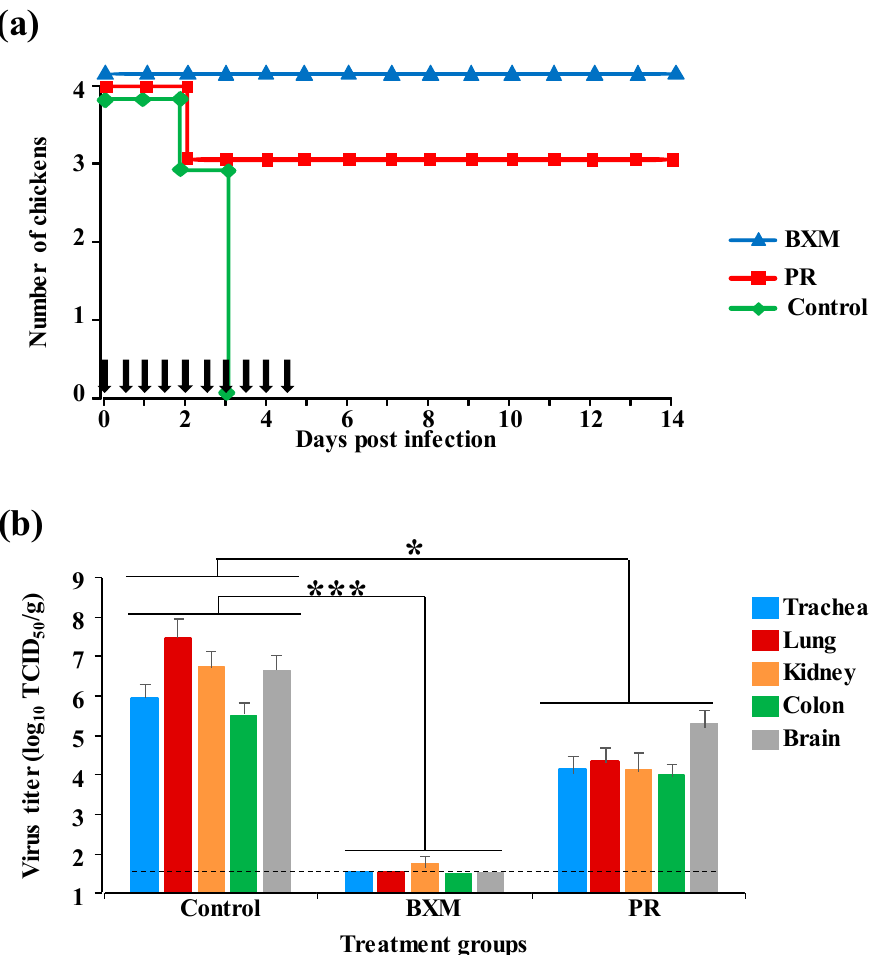
Figure 1. Effects of the simultaneous treatment using multiple doses of baloxavir marboxil (BXM) or peramivir (PR) in chickens infected with a high pathogenicity avian influenza virus (HPAIV), A/BS/Akita/1/16. Eight chickens per group were infected with 10 CLD 50 /100 µL (10 5.3 EID 50 ) of the HPAIV and treated immediately with 20 mg/kg of either BXM or PR; the untreated group was assigned as the control. ( a ) Survival of half the infected birds was followed until 14 days post-infection (dpi); vertical black arrows indicate the treatment schedule. ( b ) Virus recovery from organs collected at 3 dpi from four chickens in the control and each treatment group was assessed in monolayer Madin–Darby canine kidney (MDCK) cells. The viral titer calculated as the average ( n = 4) of each organ in the treatment group was compared to that of the control group. The black dotted line indicates the detection limit (10 1.5 TCID 50 /g), whereas the bar indicates the standard deviation. (*, p < 0.05; ***, p < 0.001).